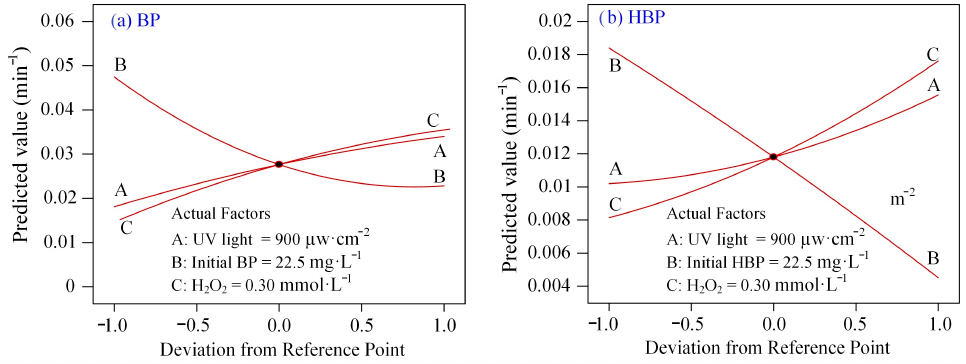
Figure 6. Perturbation graphs for ( a ) BP degradation and ( b ) HBP degradation.